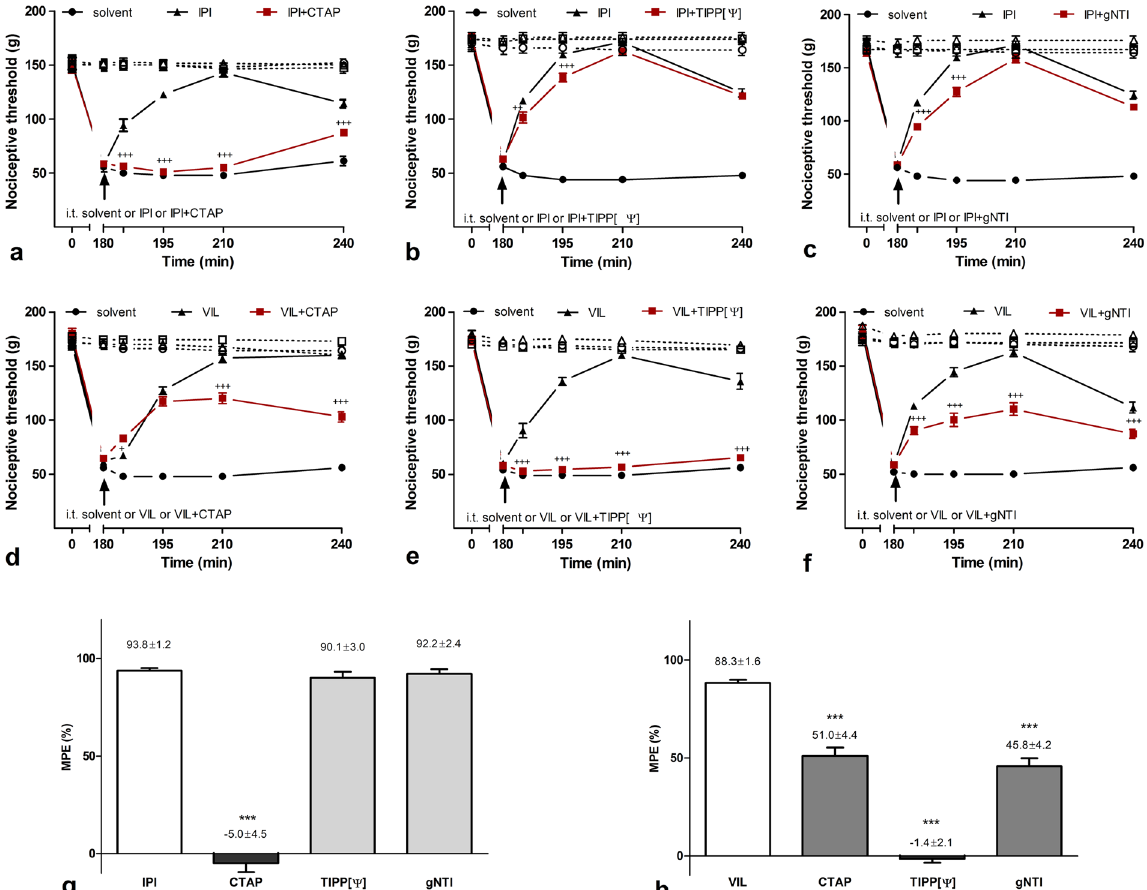
Figure 5. Antihyperalgesic effect of DPP4 inhibitor IPI and vildagliptin in carrageenan-induced inflammation. ( a ) Antihyperalgesic effect of IPI has been completely abolished by co-administartion of CTAP, but ( b ) neither TIPP[ Ψ ] nor ( c ) gNTI altered IPI-evoked antihyperalgesia. ( d ) Antihyperalgesic effect of vildagliptin was significantly reduced by CTAP and ( f ) gNTI, but was completely eliminated when ( e ) TIPP[ Ψ ] was co-injected. Inhibitory effects of opioid antagonists on IPI and vildagliptin related antihyperalgesia are summarized on bar graphs ( g ) and ( h ) constructed from data recorded 210 min after i.t. drug application. Comparisons were made with two-way ANOVA, Bonferoni post hoc test; + p < 0.05; +++ p < 0.001 ( a – f ) and one-way ANOVA followed by Dunnett’s post hoc test. *** p < 0.001 (g and h). Asterisks always indicate significant differences between the time-matching points of DPP4 inhibitor and DPP4 inhibitor + opioid antagonist curves. Data on each curves and bars are given as mean and